Question: What kind of plot is shown here?
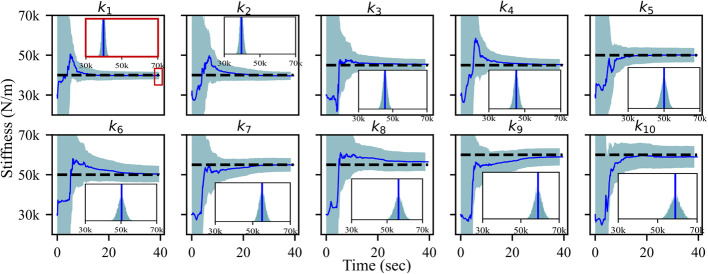
Answer: histogram